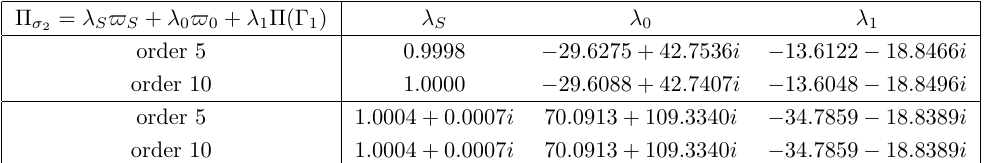
Table 1 . Linear combination of solutions for the sunset graph. In the (cid:12)rst two rows are the values for our solutions whereas the last two give the ones for the solutions from [18]. Our three-parameter solutions (3.24), (3.26) and (3.29) break down in the equal mass case 19 to the solutions of (3.30). This shows that they reproduces the well established equal mass